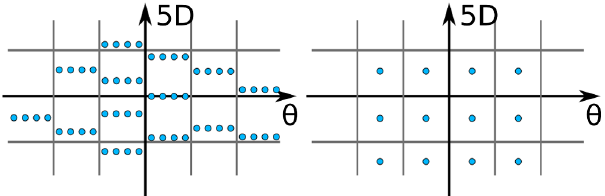
FIG. 4. Schematic illustration of beamlets (red) and member particles (blue) composing a